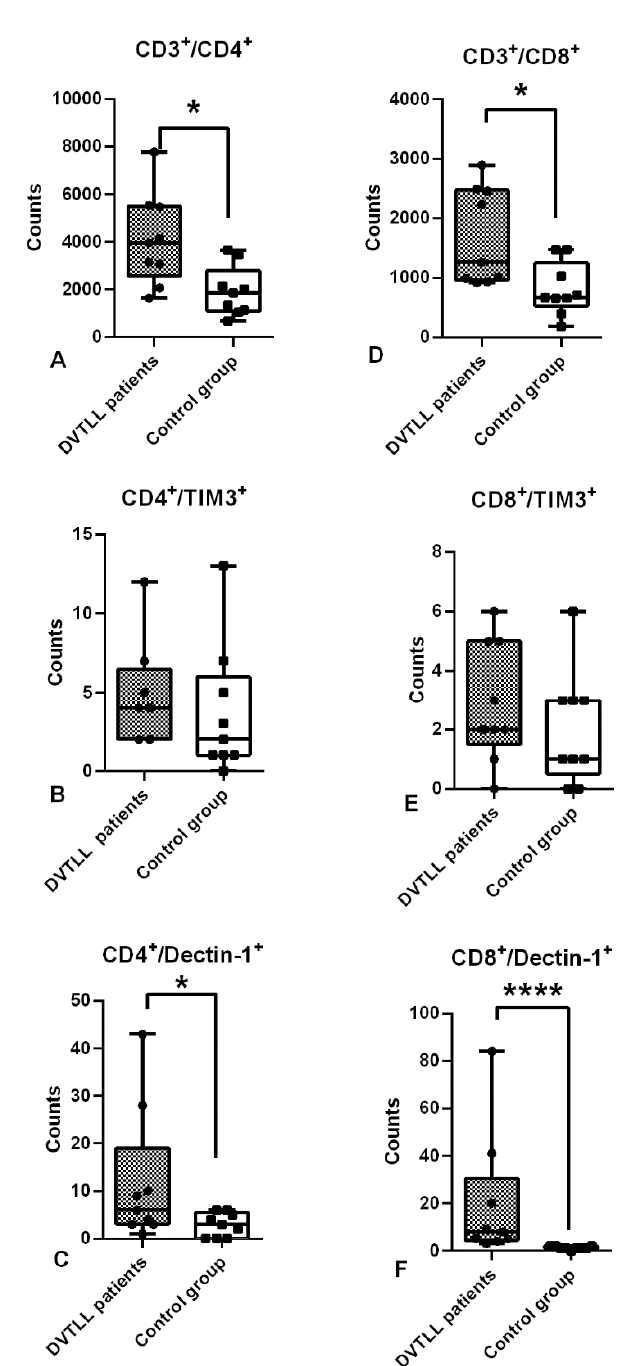
Figure 2. Expression of TIM3 and Dectin-1 in CD3 + , CD4 + and CD8 + T lymphocytes belonging to DVTLL patients and healthy controls was analysed by flow cytofluorimetric analysis. The number of CD3 + /CD4 + and CD3 + /CD8 + cells was higher in DVTLL patients ( A , D ). No differences were observed for CD4 + /TIM3 + and CD8 + /TIM3 + cells between DVTLL patients and controls ( B , E ). The number of CD4 + and CD8 + cells expressing Dectin-1 ( C , F ) was significantly higher in DVTLL patients. Statistical analysis was performed by a Mann–Whitney test. * p < 0.05; **** p < 0.0001.